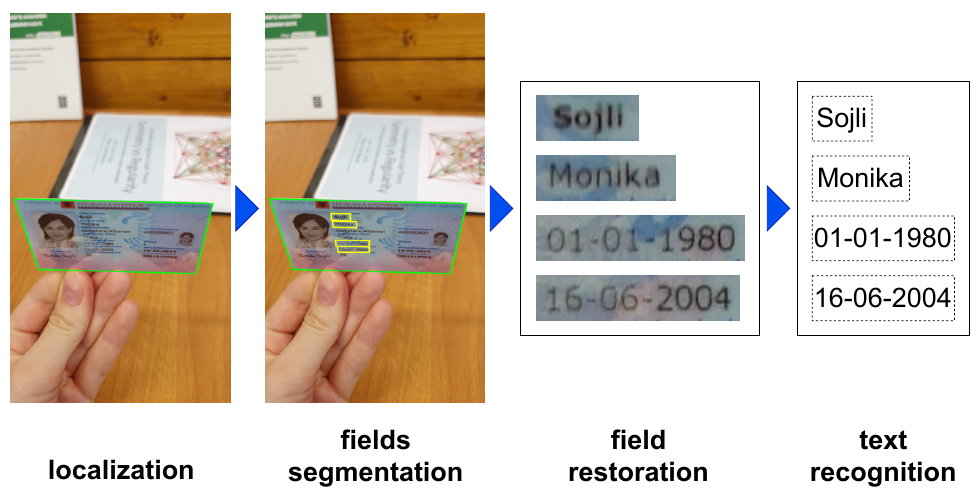
Figure 4. The general model of the document recognition